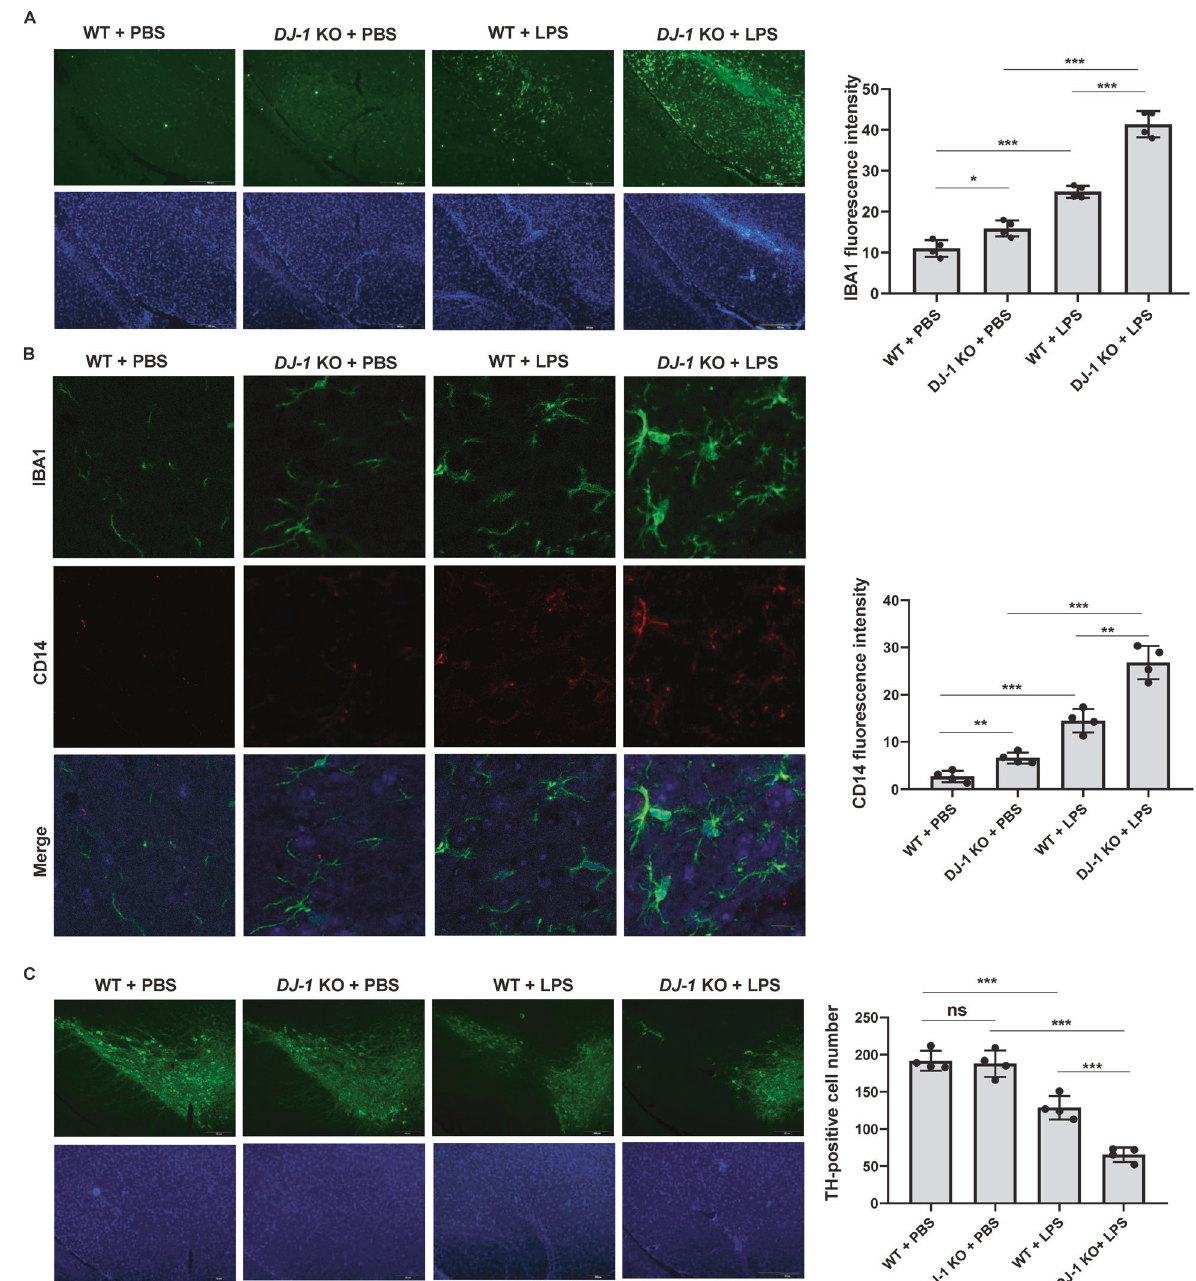
Fig. 1 DJ-1 de fi ciency leads to microglia activation and DA neuron loss in vivo. A – C DJ-1 − / − and the littermate wild-type controls were microinfused with PBS or LPS into the SN, and 14 days after injection, immunohistochemical staining was conducted. A Slices were stained with anti-IBA1 antibodies. Scale bar, 200 µm. The fl uorescence intensity of IBA1 staining was quanti fi ed. n = 4. B Slices were co-stained with anti-CD14 and anti-IBA1 antibodies. Scale bar, 20 µm. The fl uorescence intensity of CD14 staining was quanti fi ed. n = 4. C Slices were stained with anti-TH antibodies. Scale bar, 200 µm. TH-positive neuron numbers in the SN of each slice were quanti fi ed. n =